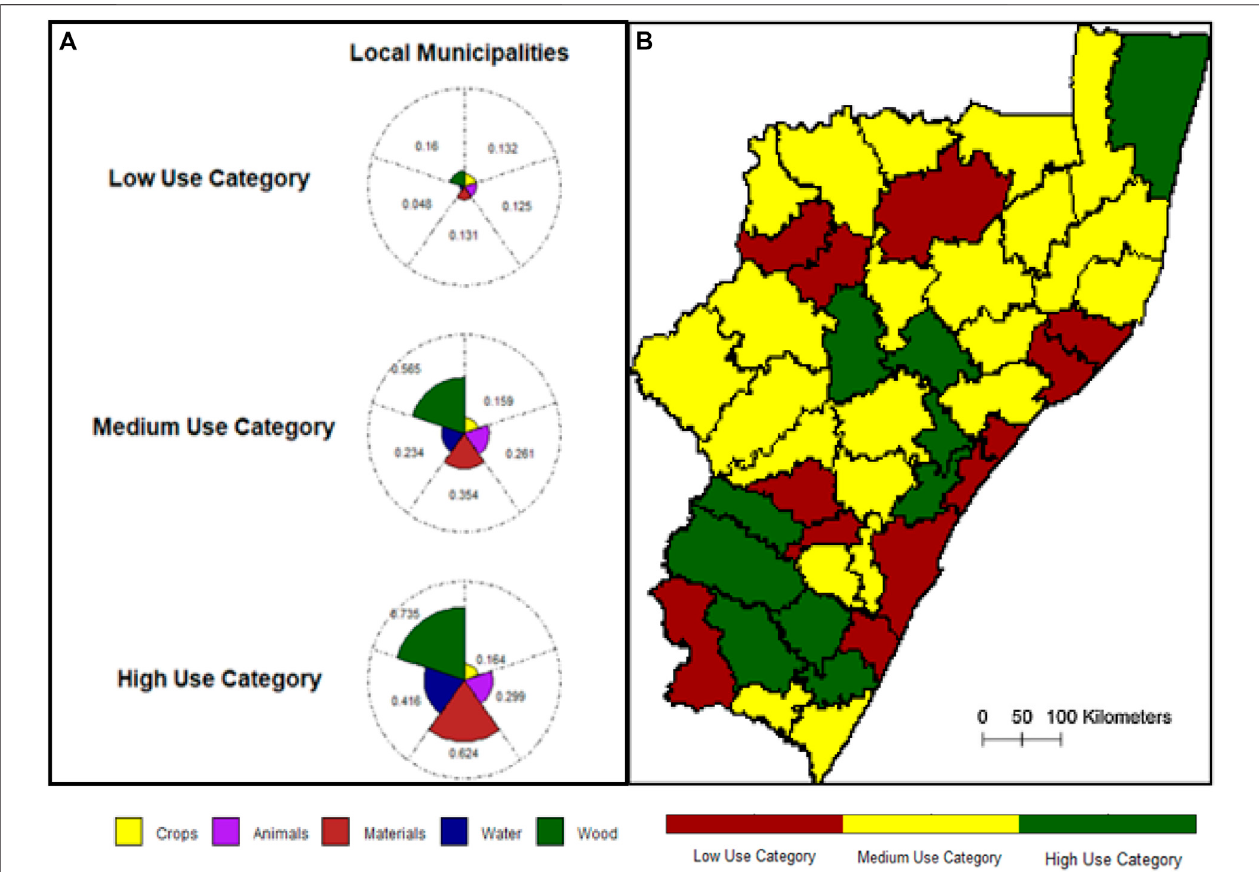
FIGURE4|(A) TypicalcompositionofdirectESuseatmunicipalitylevel.Lowusecategorycorrespondstoredloops,mediumtotransitionloopsandhightogreen loop types of SES. Petal lengths indicate the average percentage of households in a given category using one direct ES. Standard errors (se) range within se ε (0.008; 0.042). (B) Distribution of use categories across KwaZulu-Natal. Data: Census 2011 and of fi cial shape fi le data for border